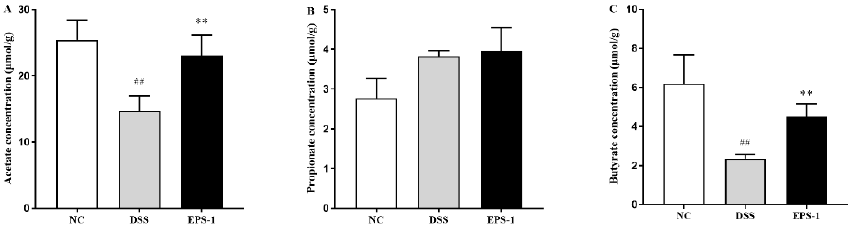
Figure 6. Effect of EPS-1 administration on SCFAs in contents. ( A ) acetate, ( B ) propionate, and ( C ) butyrate. Data are presented as mean ± SD. ## p < 0.01 vs. the NC group, ** p < 0.01 vs. the DSS group by using one-way analysis of variance, followed by Duncan’s test.